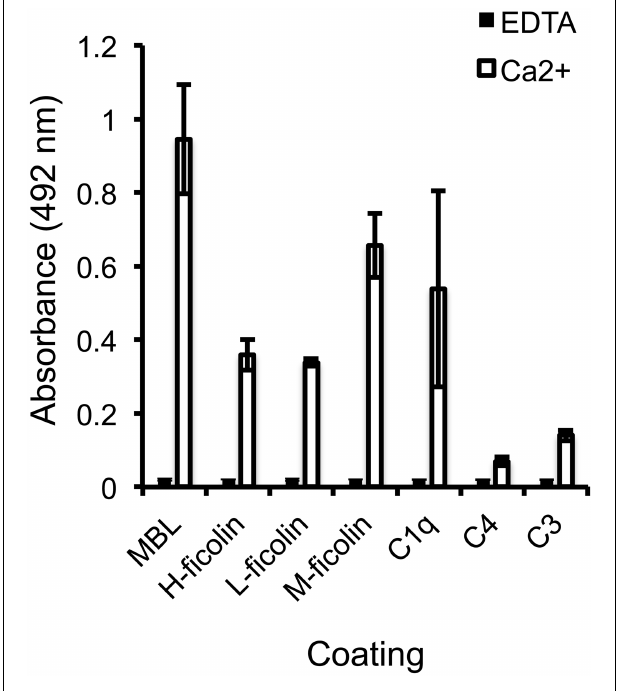
FIGURE 2 | Interaction of SALSA with complement proteins. MBL, M-ficolin, L-ficolin, H-ficolin, C1q, C4, and C3 (1 μ g/ml) were coated on a plate followed by incubation with rSALSA (0.5 μ g/ml) in either a Ca 2 + - or EDTA-containing buffer. SALSA bound strongly to MBL, but also binding to all three ficolins and C1q was observed. Only a weak interaction with C4 and C3 could be seen. In the presence of EDTA, no binding of SALSA occurred.The averages and standard deviations (SDs) of two experiments performed in duplicate are shown.